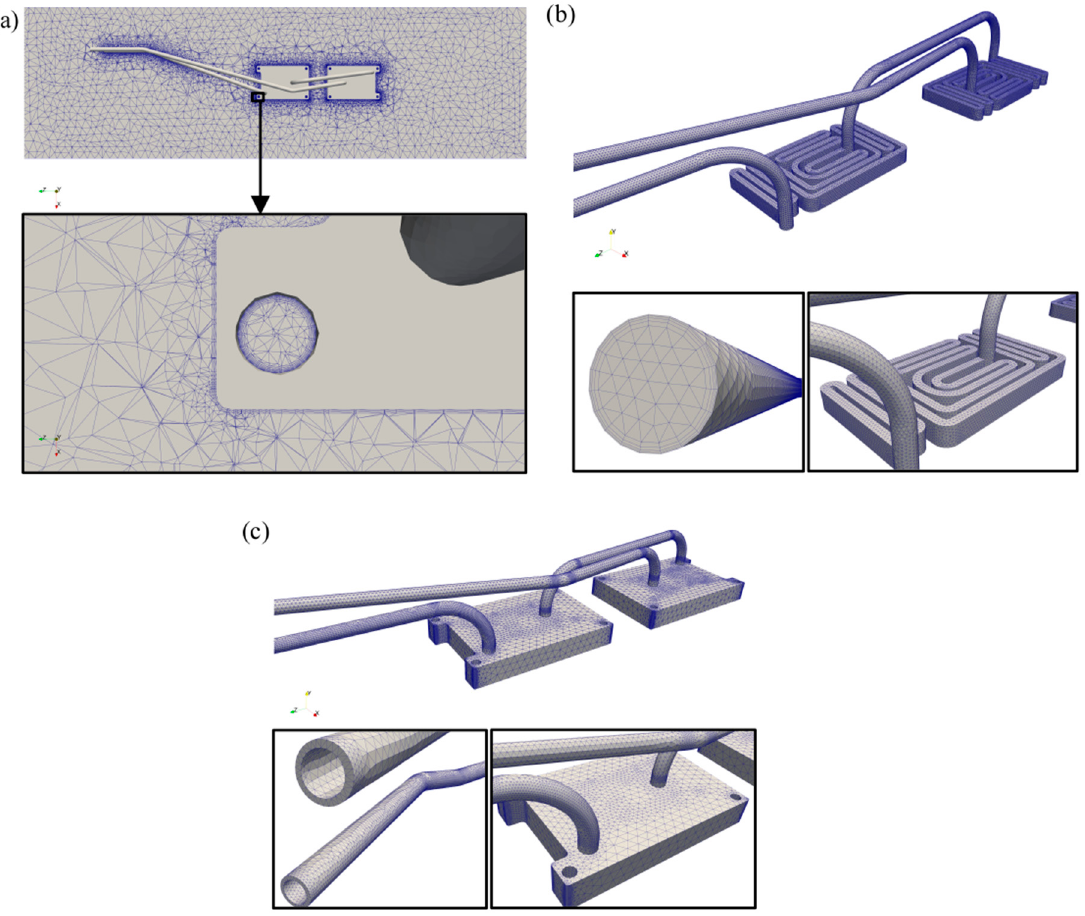
Figure 10. Distant and close-up views of the multi-region mesh for ( a ) air, ( b ) water and ( c ) solid